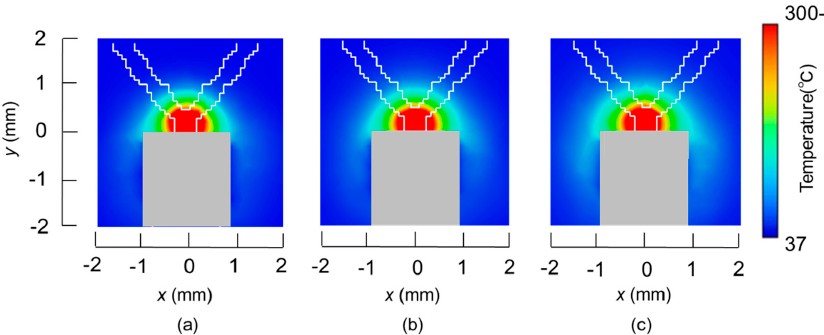
Figure 5. Temperature distributions of the high frequency snare at z = − 0.3 mm.